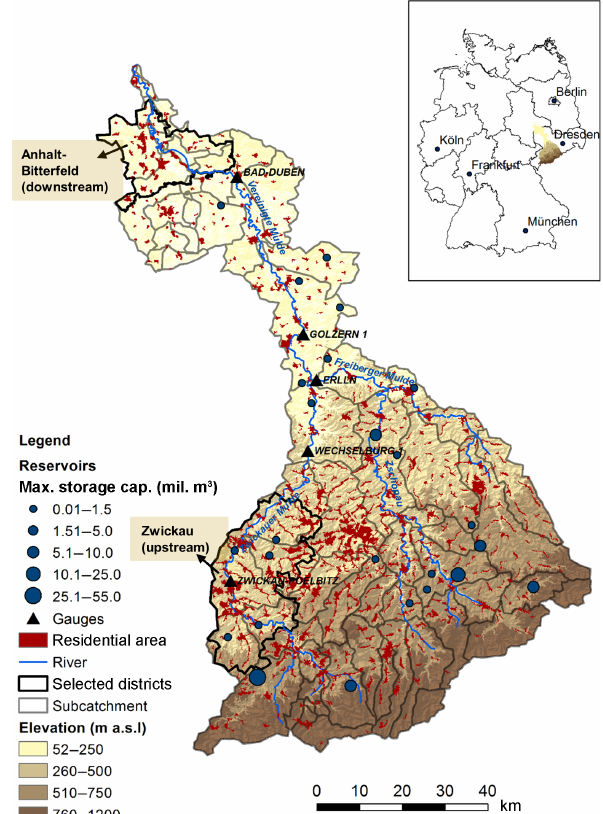
Figure 1. Study area of the Mulde catchment, including the main tributaries, reservoirs, and river gauges. The inset shows the location of the catchment within